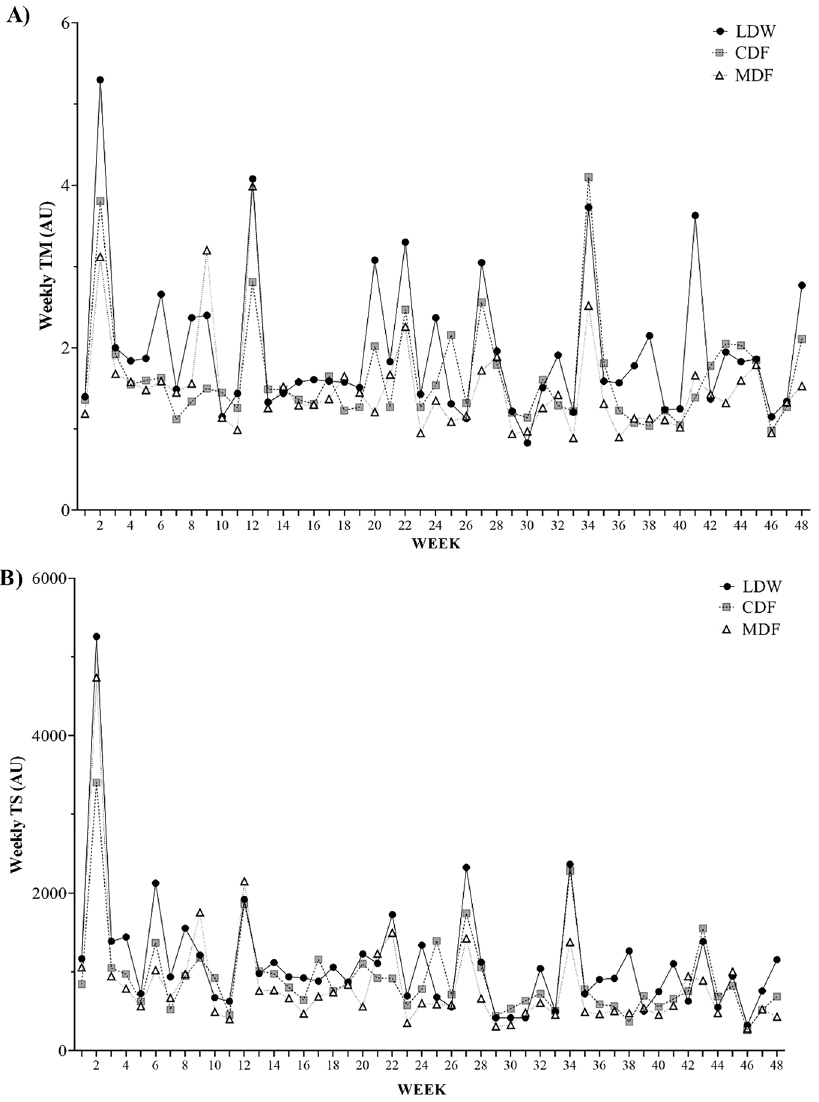
Figure 2. Overall vision of the ( A ) Weekly TM and ( B ) Weekly TS variations across the full season by play